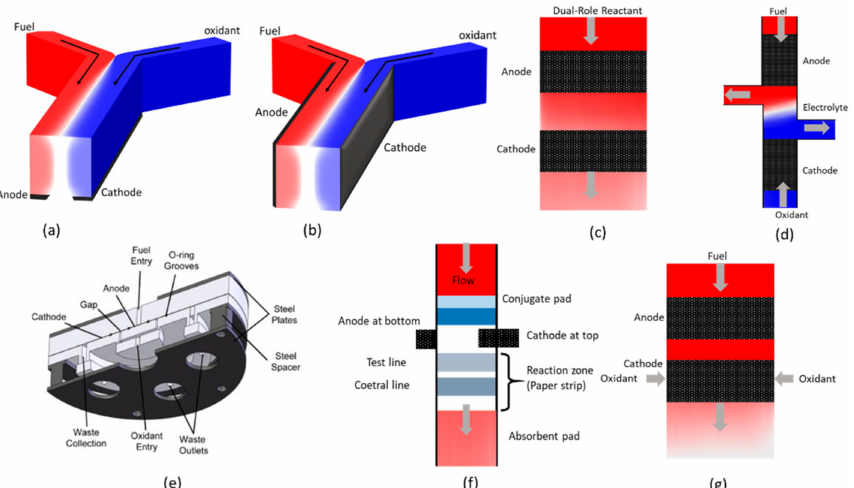
Figure 2. Evolution of MMFC: ( a ) side-by-side streaming co-laminar flow MMFC (CLFMMFC), ( b ) vertical-layered streaming CLFMMFC, ( c ) single-stream MMFC (SSMMFC), ( d ) counter-flow MMFC (CFMMFC), ( e ) radial-flow MMFC (RFMMFC) (reprinted from ref. [35]. Copyright 2008 Elsevier), ( f ) lateral-flow MMFC (LFMMFC), and ( g ) orthogonal-flow MMFC